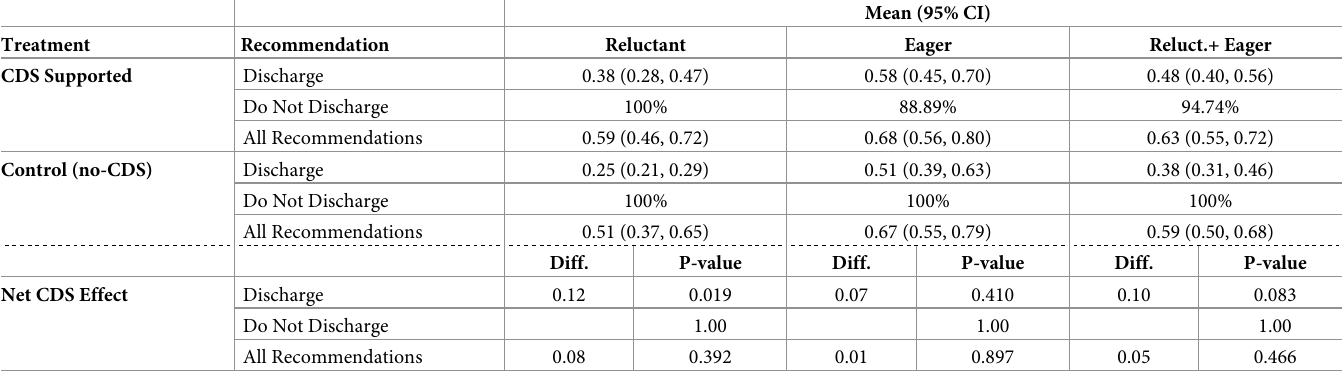
Table 3. Concordance between decision-support recommendation and study participants’ decisions to discharge stratified by standardized patient preferences about discharge.